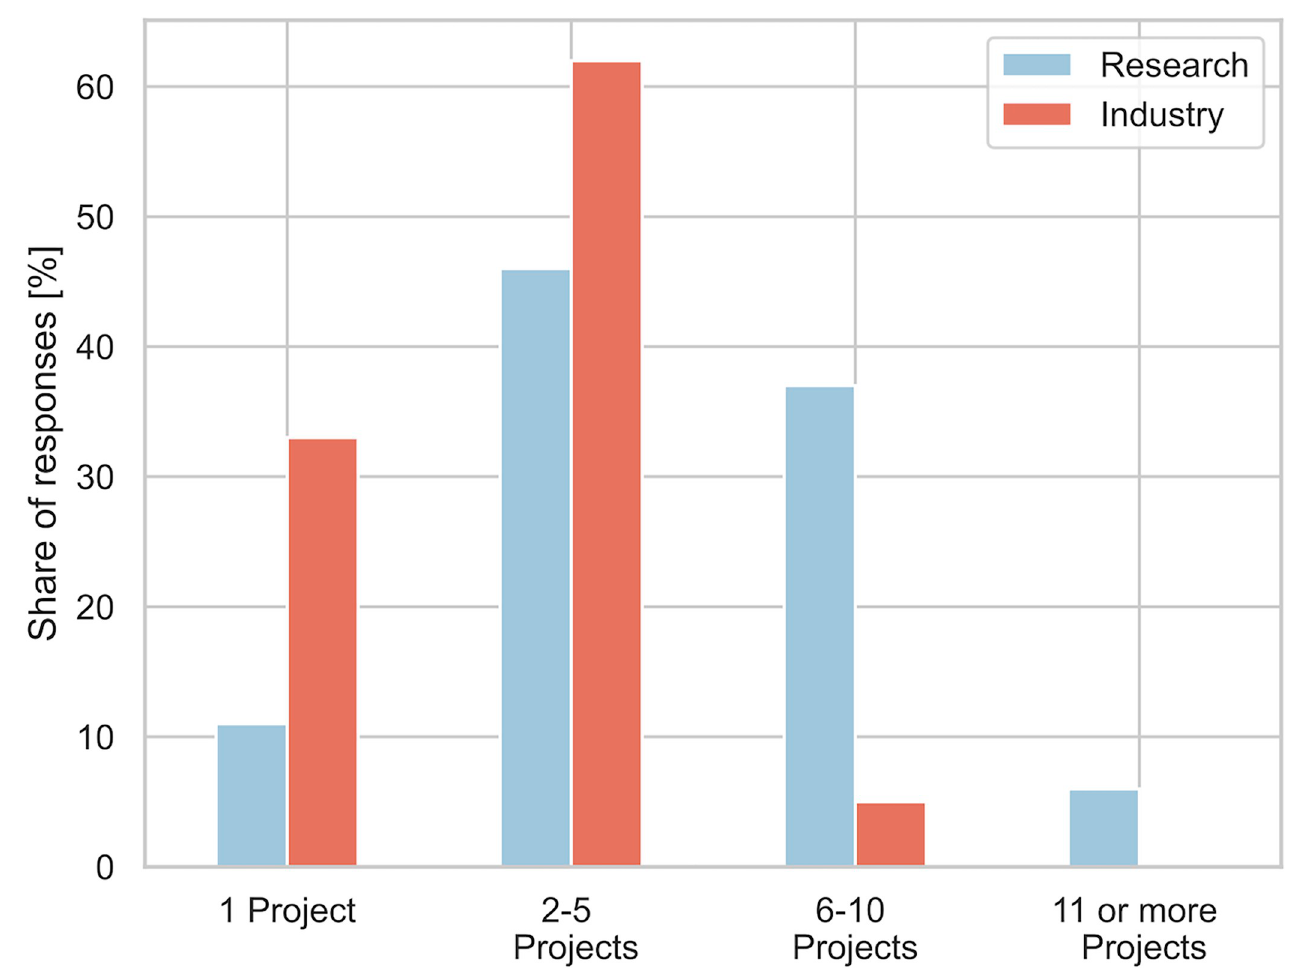
Fig 9. Share of responses for the different categories; responses were collected as single choice for the categories shown on the x axis. Each bar represents the share of responses for the respective category.